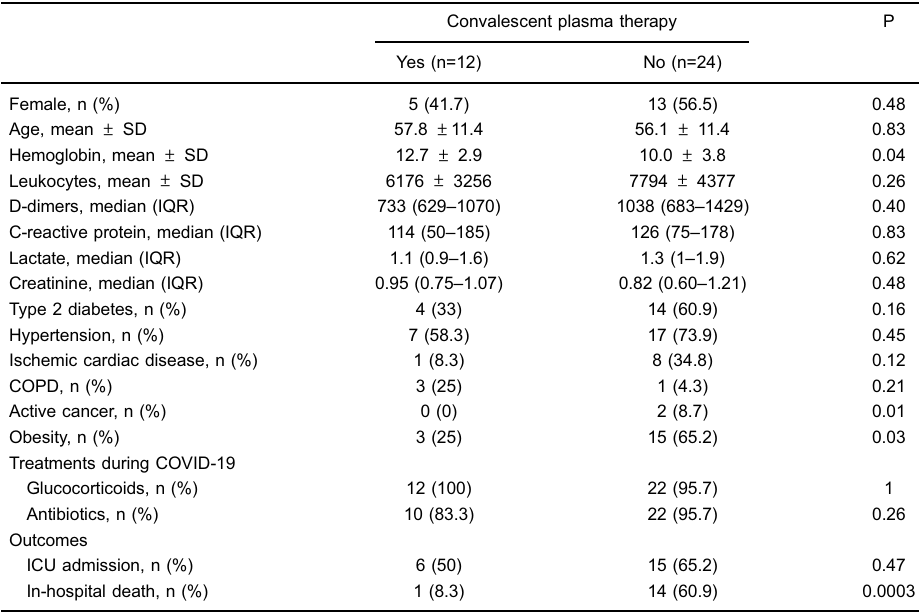
Table 1. Characteristics and outcomes of patients included in the study according to convalescent plasma